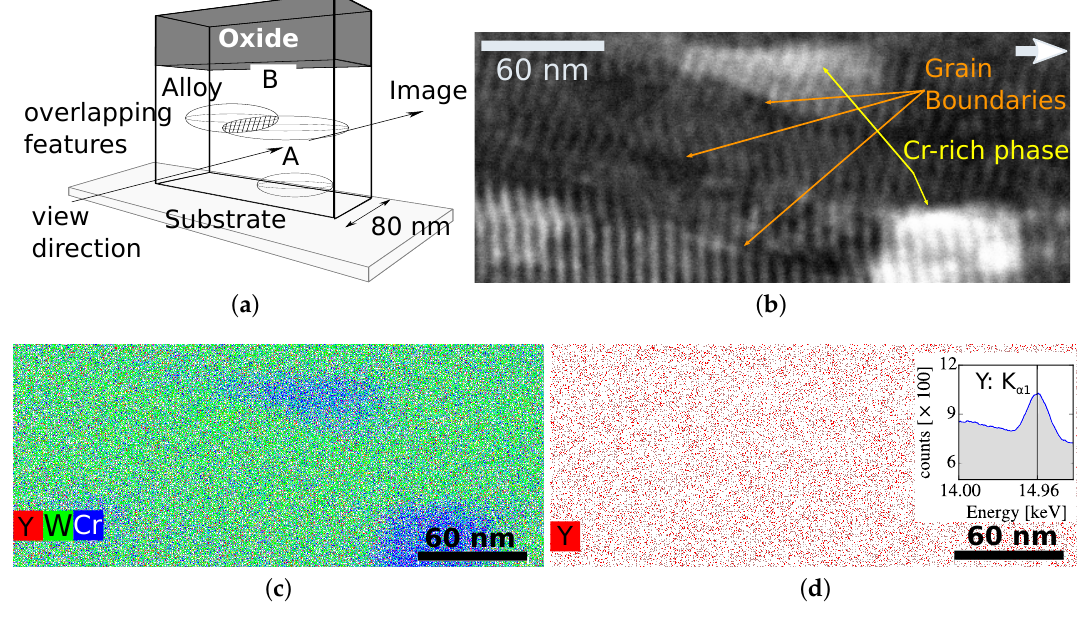
Figure 8. ( a ) Schematic drawing of the lamella, not in scale. A, and B mark regions where measurements are conducted; ( b ) STEM measurement in region A from ( a ). The alloy W-12Cr-0.5Y is oxidized at a temperature of 1273K at 20kPa O 2 and 80kPa Ar partial pressure for 75min. The white arrow on top right points towards the surface oxide layer; ( c ) EDX measurement map of tungsten, chromium, and yttrium overlaid; ( d ) EDX measurement map of yttrium and the spectrum added up over the whole mapping area in the